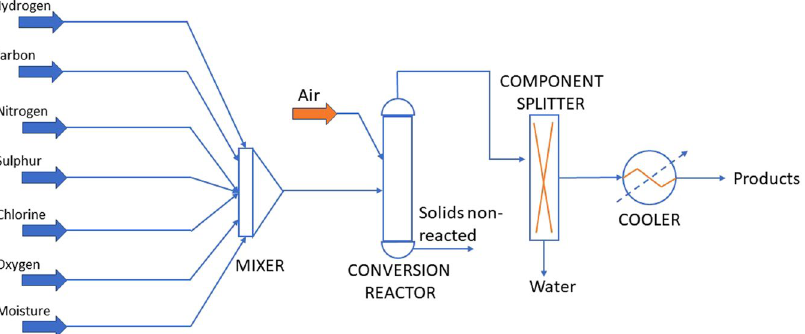
Figure 2. Schematic diagram of the units (in uppercase) and streams (in lowercase) used to simulate the pyrolysis and combustion runs in the Aspen HYSYS chemical process